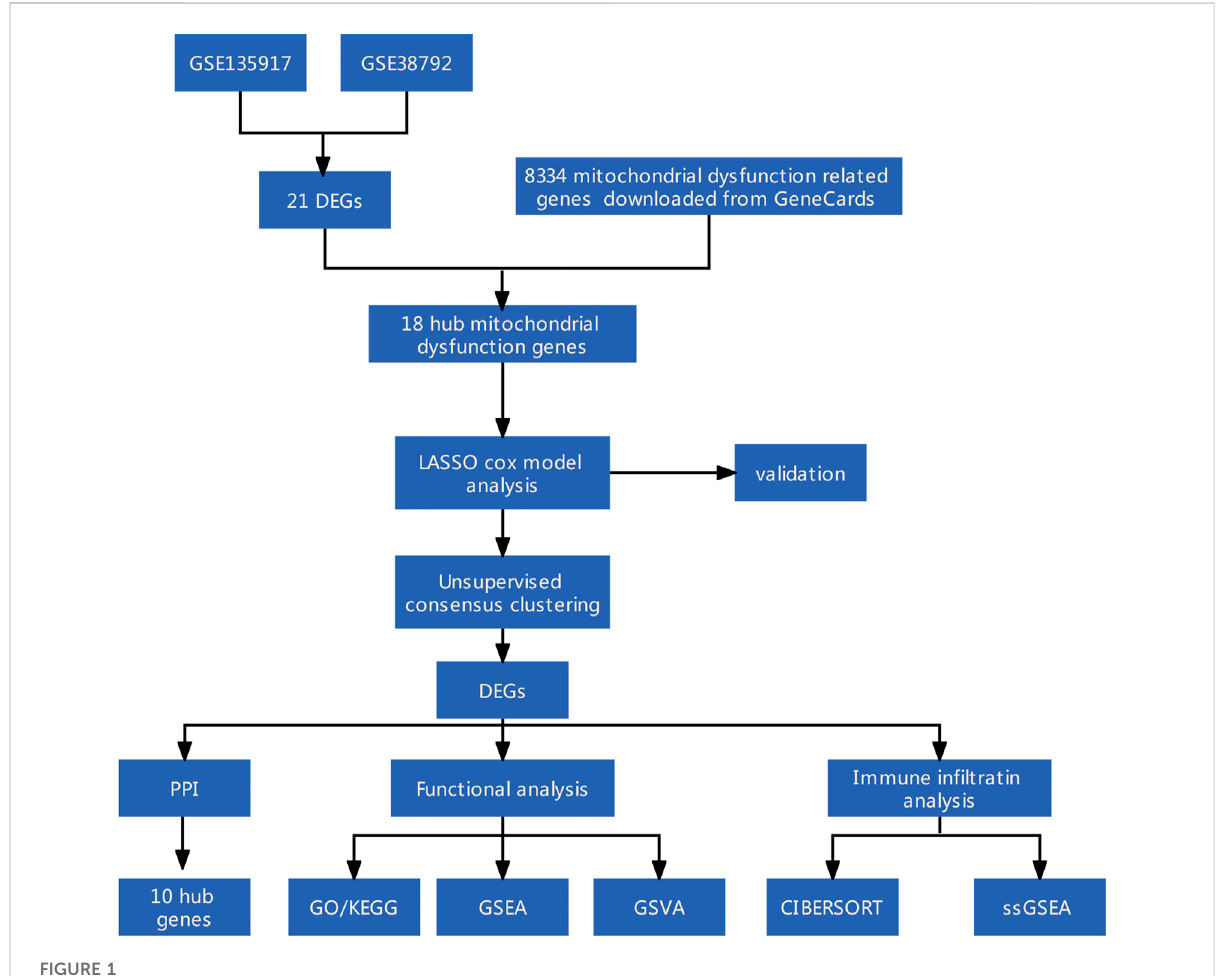
FIGURE 1 Flow diagram of methodologies used in this